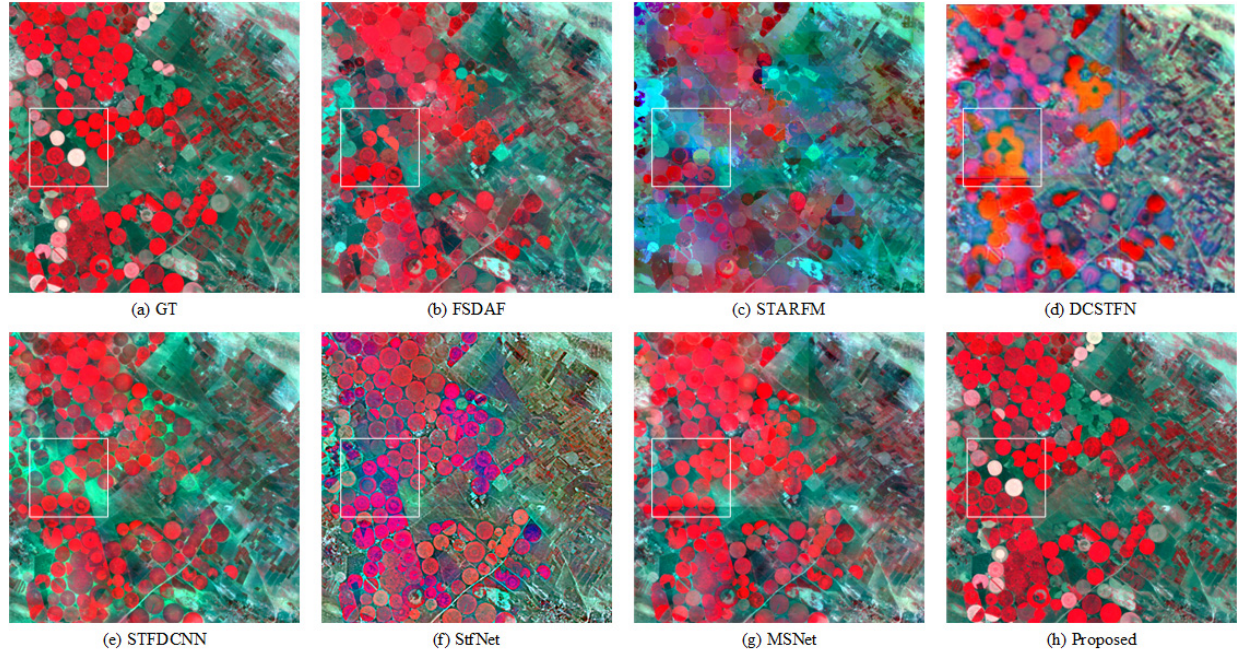
Figure 13. Second specific prediction results for the target Landsat image (7 July 2015) in AHB dataset. Among them, the white framework is the prominent difference of the results obtained by each method. Comparison methods include FSDAF [11], STARFM [8], DCSTFN [23], STFDCNN [18], StfNet [19], and MSNet [36], which are represented by ( b – g ) in the figure respectively. ( a ) represents the ground truth (GT), and ( h ) represents the proposed method.